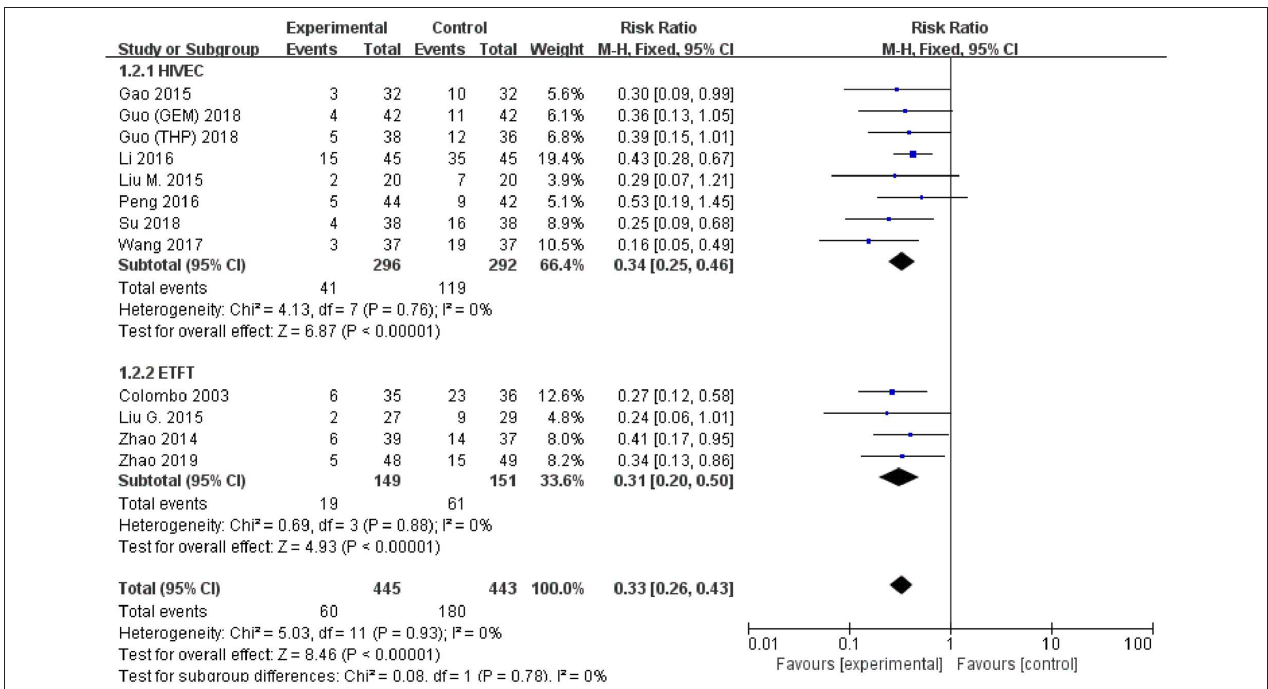
FIGURE 5 | Comparison on recurrence rate between thermal intravesical chemotherapy and normal temperature intravesical chemotherapy after subgroup analysis stratified by different approach used in thermal therapy.